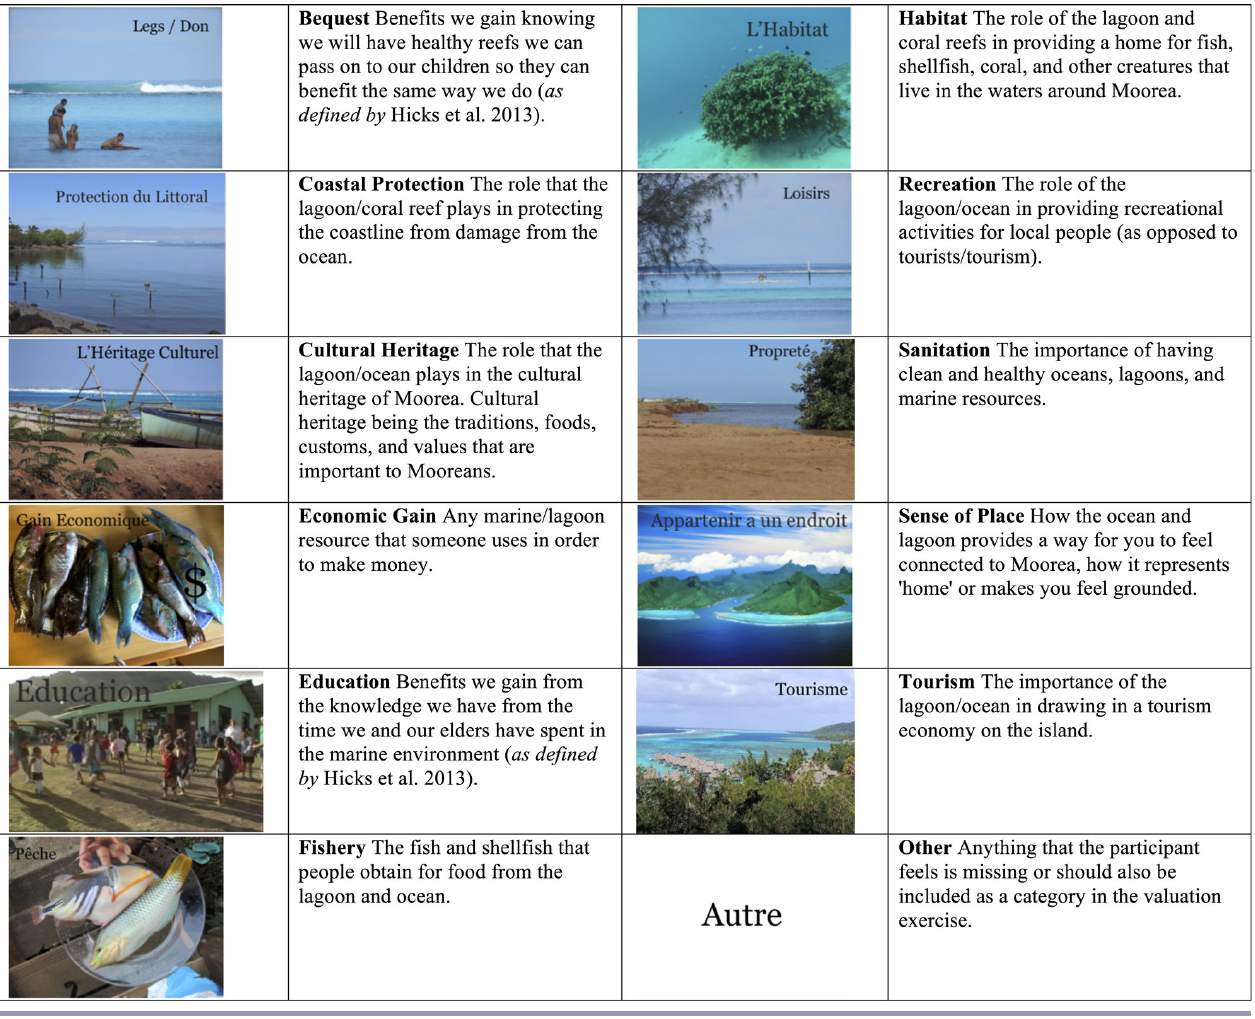
Fig. 2 . Photo cards and definitions of ecosystem services that were assigned points to demonstrate their importance by respondents from four profession